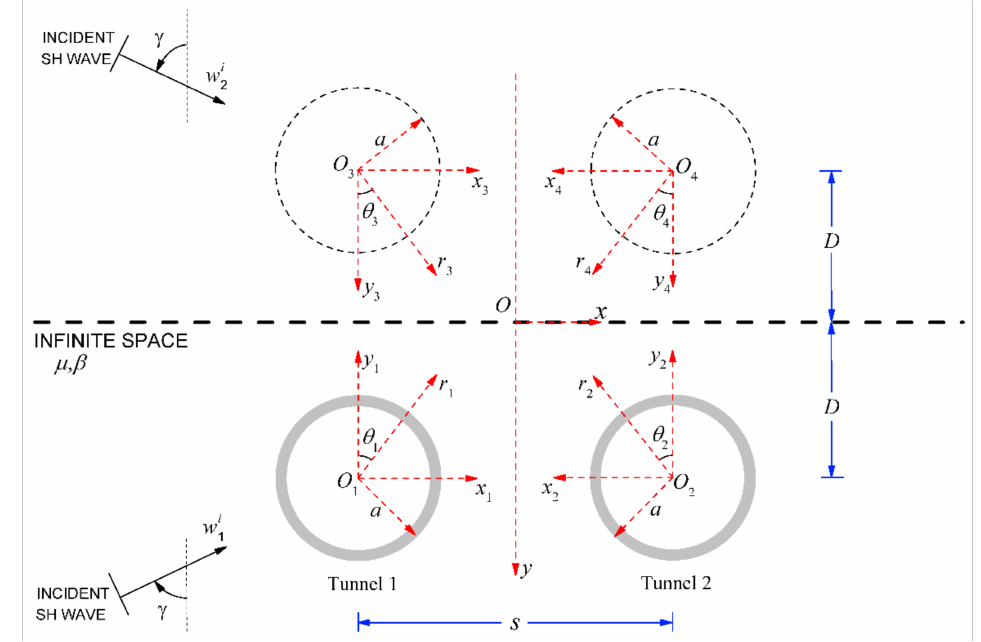
Figure 2. Twin tunnels and their